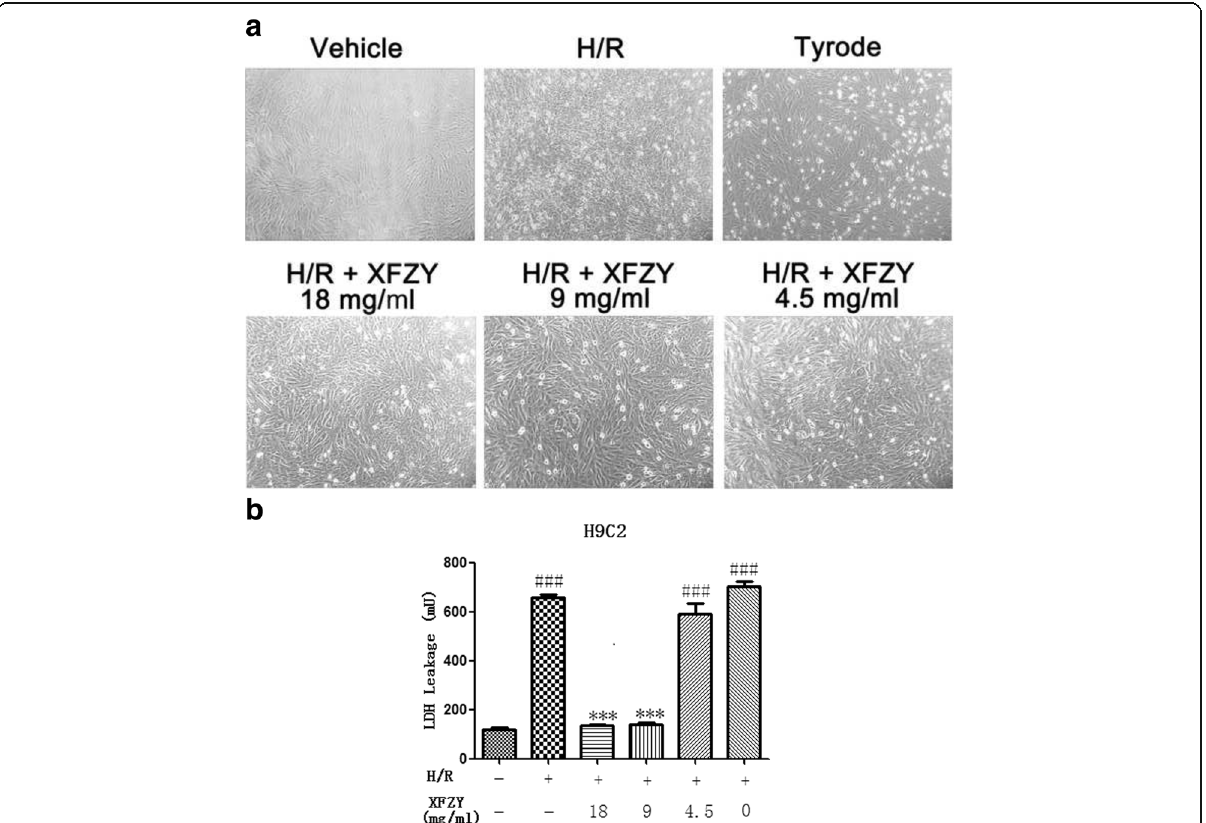
Fig. 3 Protection of XFZY against H/R-induced cardiomyocyte injury. Myocardial H9C2 cells were incubated with different concentrations of XFZY under hypoxia for 10 h and reoxygenated for 2 h. a After H/R, cells were observed under an optical microscope for morphological changes; b LDH released from H9C2 cells was assayed after H/R injury. The results were expressed as mean ± SD. ***p < 0.001 vs H/R group; ### p < 0.001 vs Vehicle group. Vehicle: normoxia; H/R: